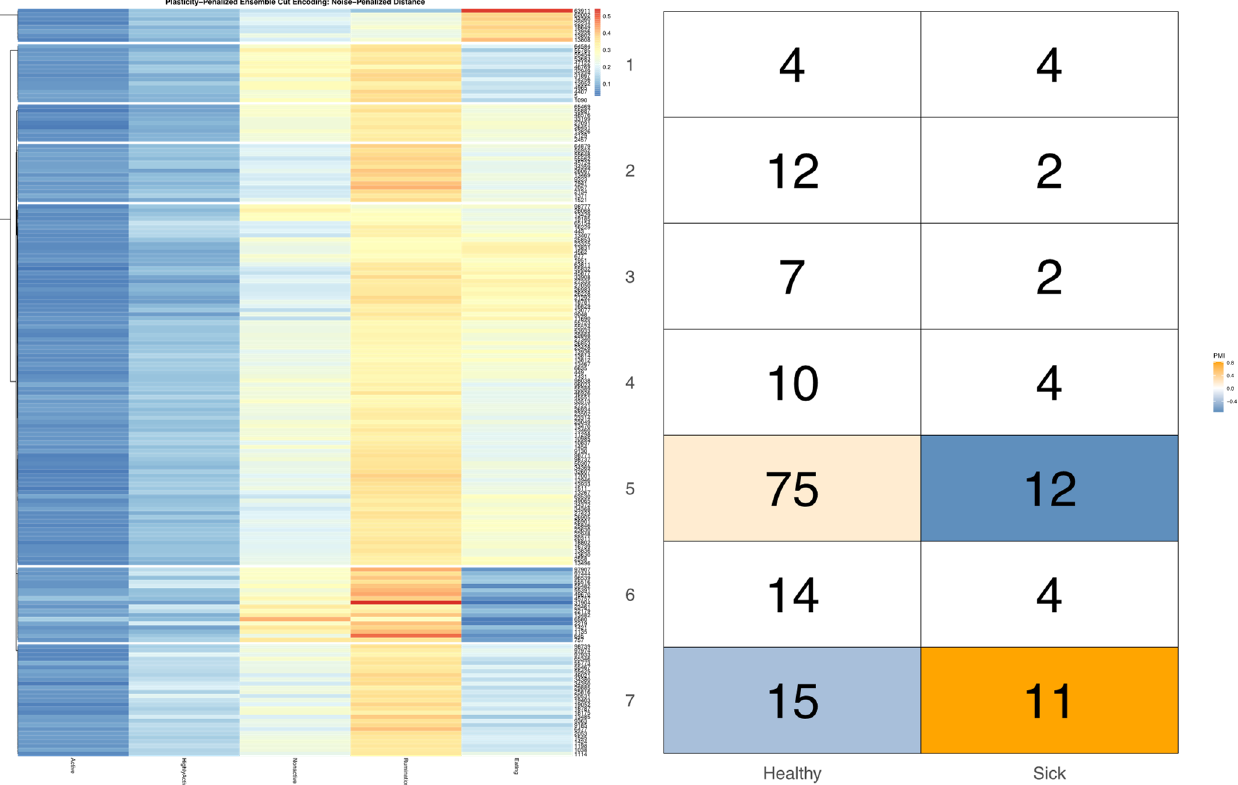
Figure 6. Visualization produced using the compareEncoding utility with cells colored by pointwise mutual information estimates significant at the alpha = 0.05 significance level after simulations using multinomial resampling. Cows with the most moderate time budgets were overrepresented among animals with no recorded health events, while sick cows were overrepresented in the overall time budget cluster characterized by relatively low time spend eating and low-to-moderate amounts of time spent nonactive.